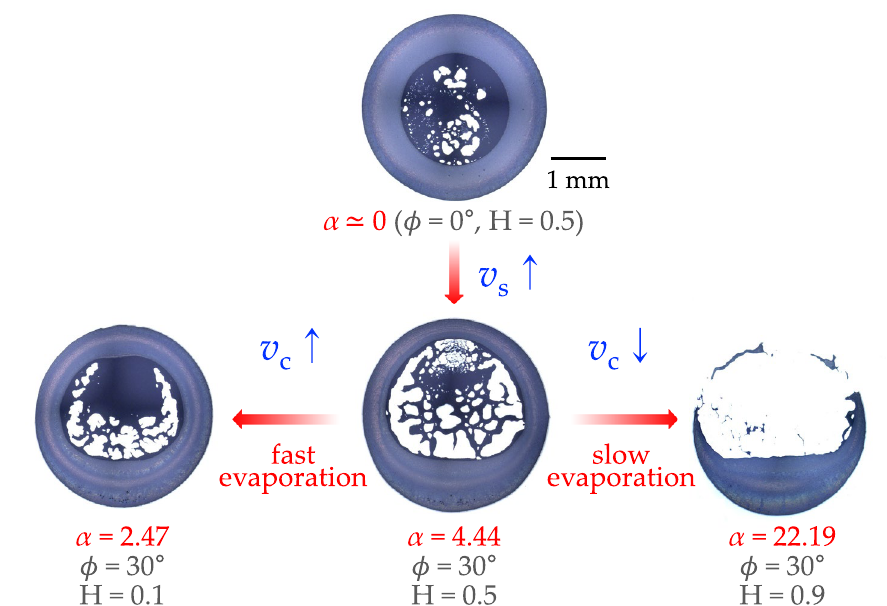
Figure 2. Final deposits of colloidal particles (particle diameter = 2 µ m) according to the relative humidity and the inclination angle. The speed ratio α is estimated from Eq.